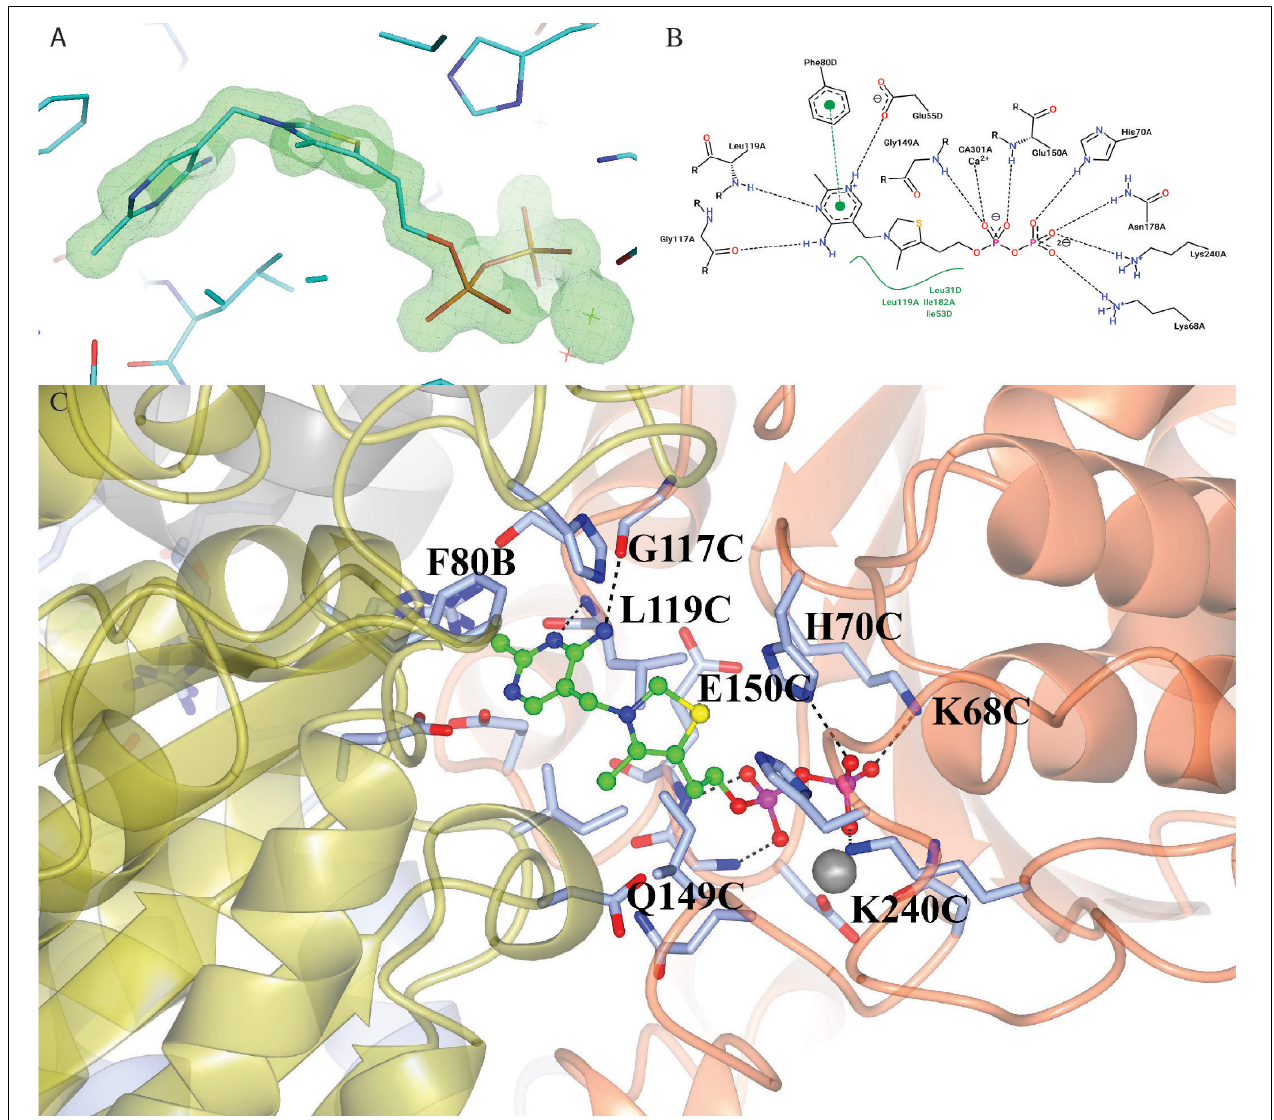
FIGURE 7 | (A) Electron- density map showing the TPP and Ca 2 + ligands bound in the active site of ChTK-F. The weighted F 0 -F c omit map, where ligands where not used in the phase calculations, is shown in green and is contoured at 5.0 sigma. The neighboring residues are shown as stick models and the Ca 2 + ion is shown as a green star. The figure was prepared using the PyMOL Molecular Graphics System, Version 2.0 Schrödinger, LLC. (B) A 2-D representation of the TPP binding site between ChTK-N (Chain-A) and ChTK-C (Chain-D). Hydrogen, ion and metal interactions between protein and ligands are drawn as dashed lines. Hydrophobic contacts are represented indirectly by spline section highlighting of the hydrophobic part of the ligand and the label of the contacting amino acid. (C) A cartoon model of the TPP and Ca 2 + binding site between ChTK-N (ice-blue) and ChTK-C (gray) subunits. The TPP molecule is shown as a ball and stick model with carbon atoms colored in green. Amino acid side chains of residues implicated in ligand binding are shown stick models with the hydrogen bonds as black dashes. The Ca 2 + ion is shown as a gray sphere with its interactions with the TPP molecule and amino acid side chains as red